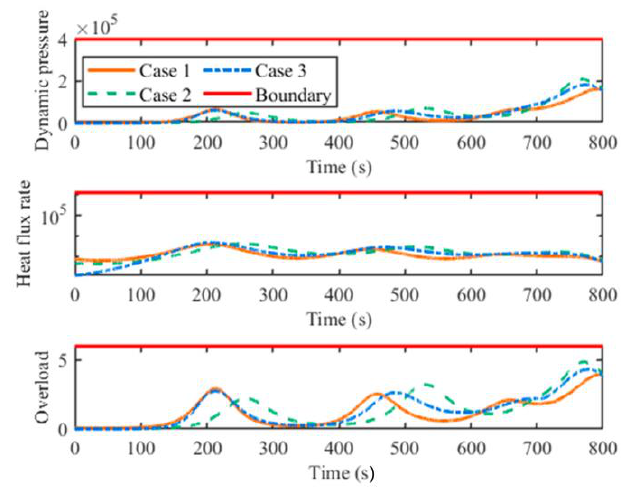
Figure 17. Time histories of the remaining voyage.